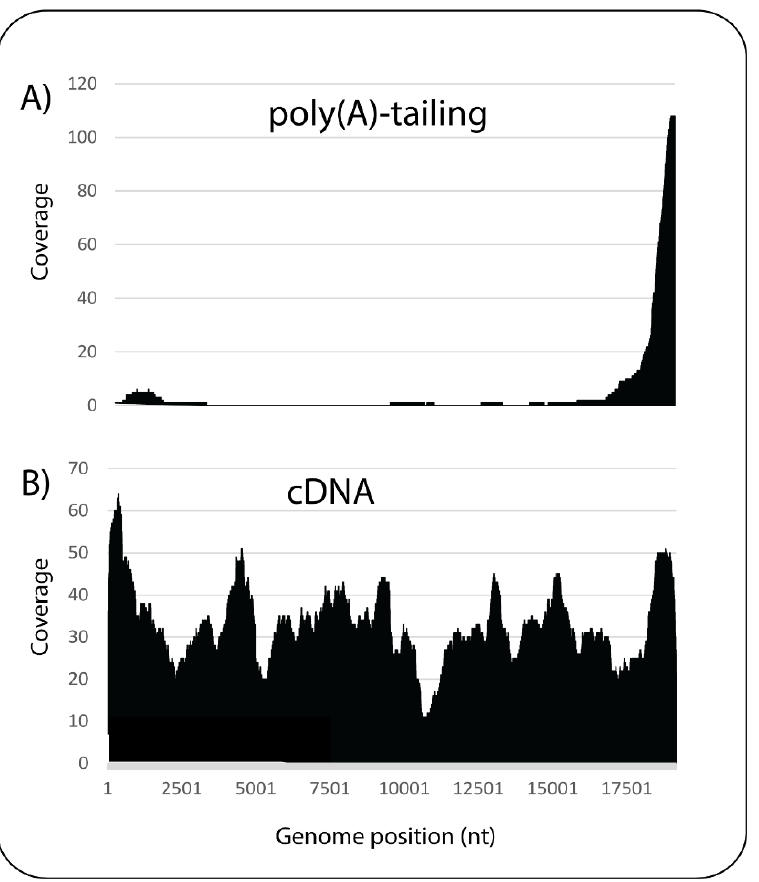
Figure 3. Read coverage plots mapping to citrus tristeza virus, comparing the poly(A)-tailing method ( A ) and the random primed ds cDNA method ( B ). Numbers on the x-axes refer to genome nucleotide (nt) position.